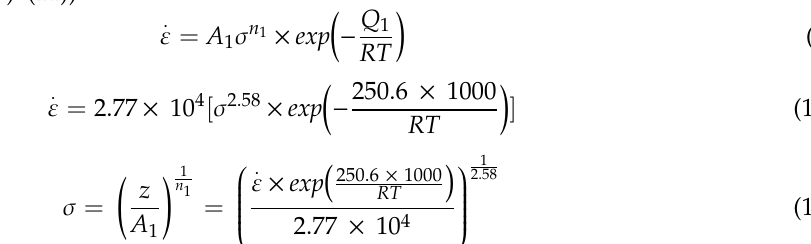
10.22 2.5 / 0.4 250.6 13.6 0.05 220.4 0.019 19 1.97 242 * The strain rate sensitivity m -index values were calculated as m = 1